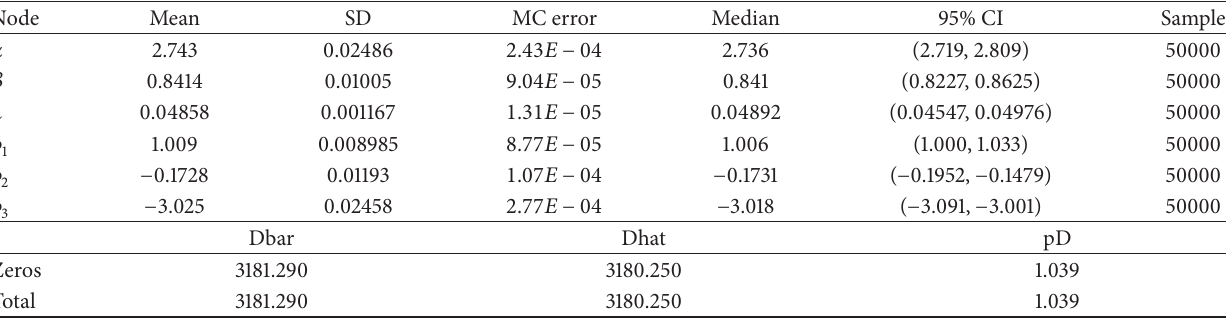
Table 5: Summary results of the posterior parameters for exponentiated Weibull for Black Hispanic females breast cancer patients ( 𝑛 = 298 ).